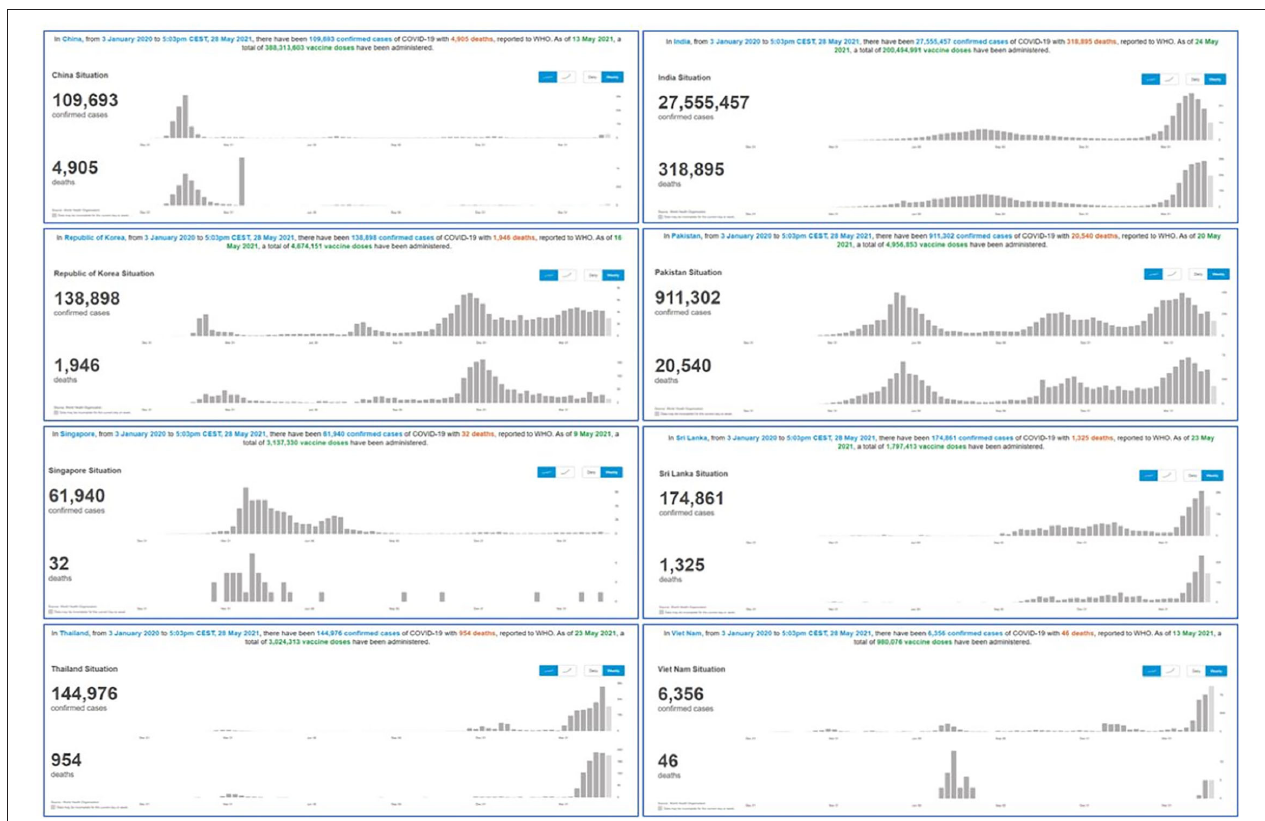
FIGURE 3 | Summary of COVID-19 outcomes in PSI implemented Asian countries. WHO’s dashboard of COVID-19 (50) related outcomes from January 2020 till 31st May 2021 reflecting the total number of confirmed COVID-19 cases and total number of death due to COVID-19 is Asian countries (China, India, Republic of Korea, Pakistan, Singapore, Srilanka, Thailand and Vietnam). The histogram showing the changes of outcome over the period of